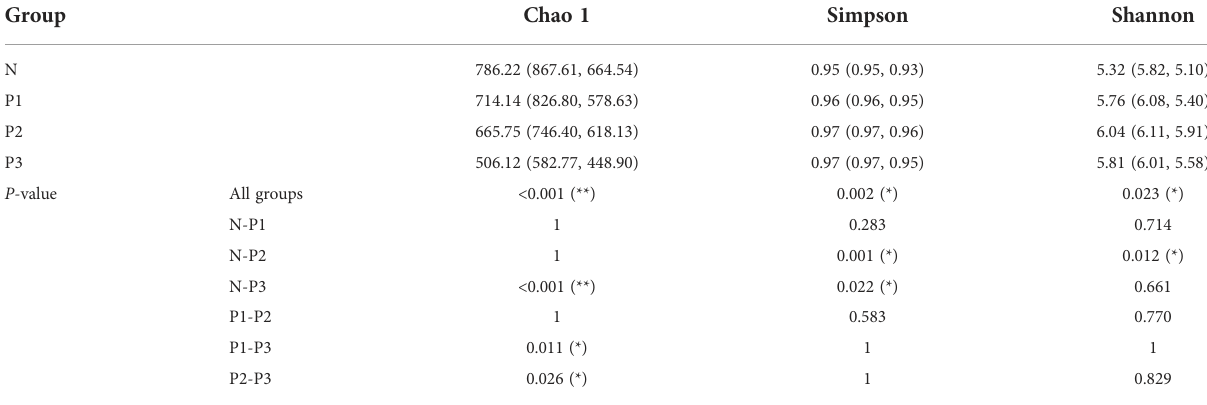
TABLE 2 Alpha-diversity indices of N, P1, P2, and P3. Group